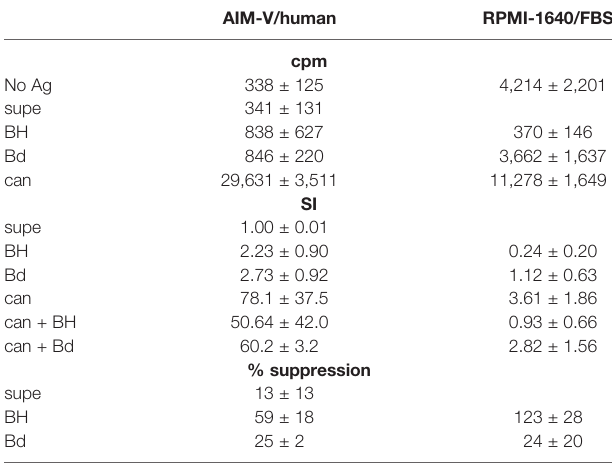
TABLE 1 | Effects of tissue culture media on